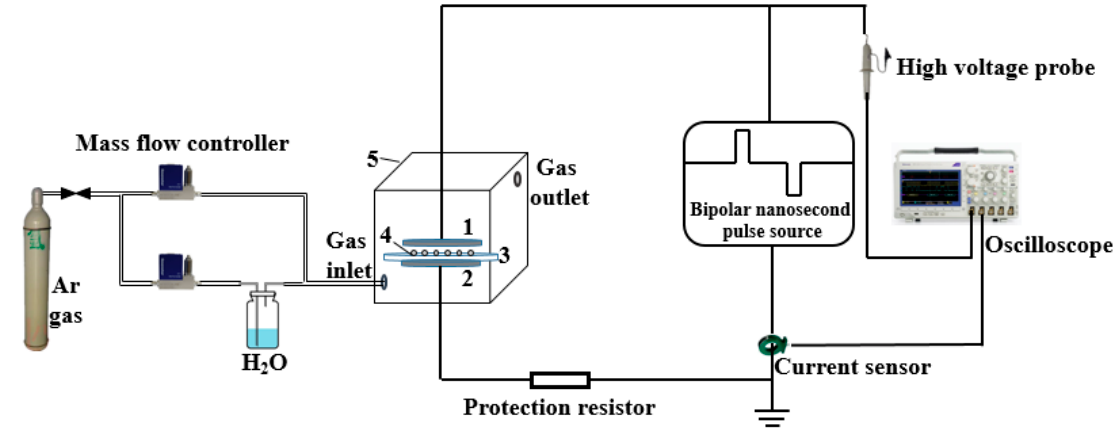
Figure 2. Schematic diagram of plasma modification of BNNSs. 1: High voltage electrode, 2: ground electrode, 3: silica glass, 4: BNNSs, 5: glass box.